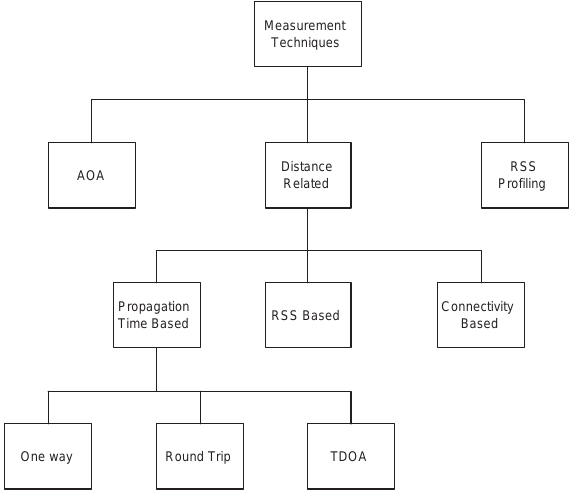
Figure 1. Classification of measurement techniques for localization